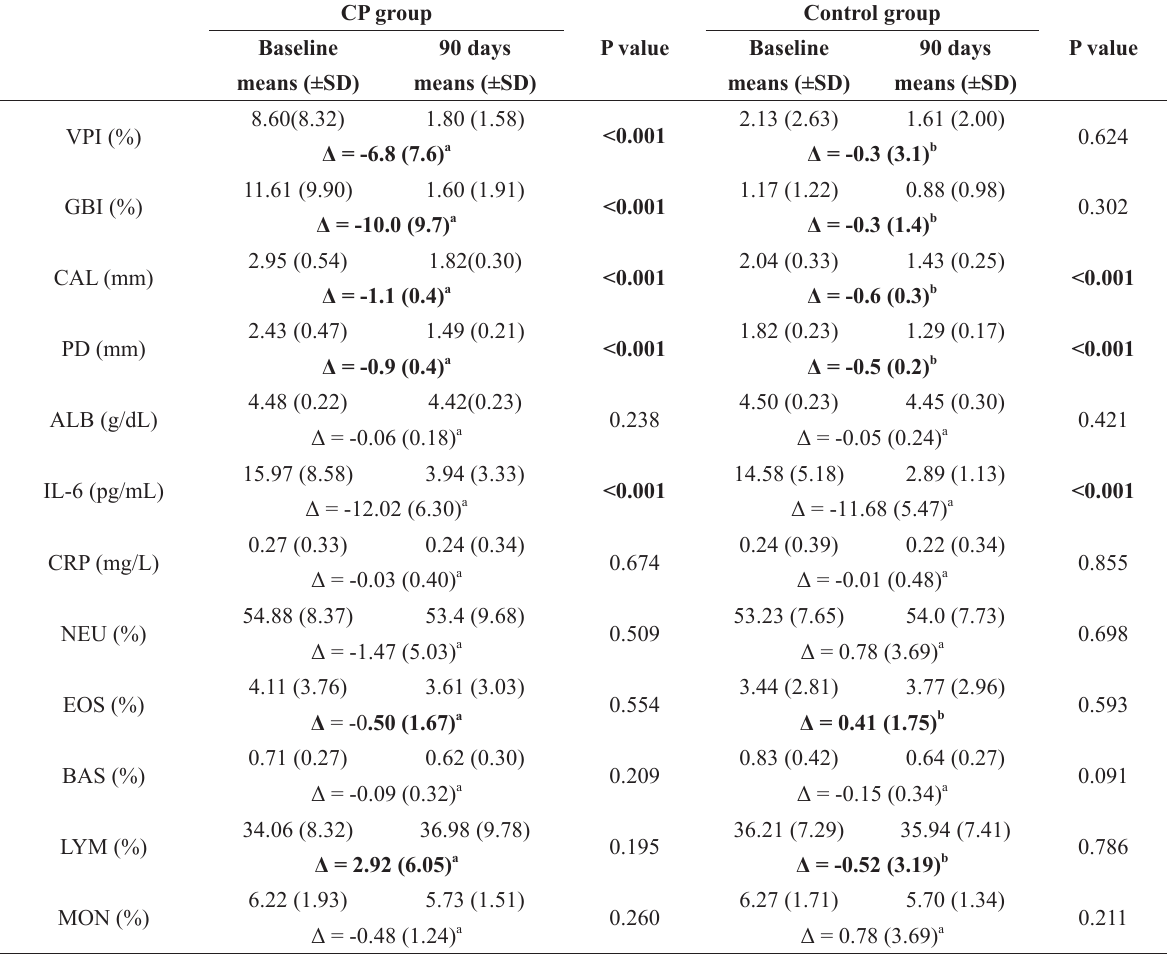
Comparison of variables changes after non-surgical periodontal therapy between the study